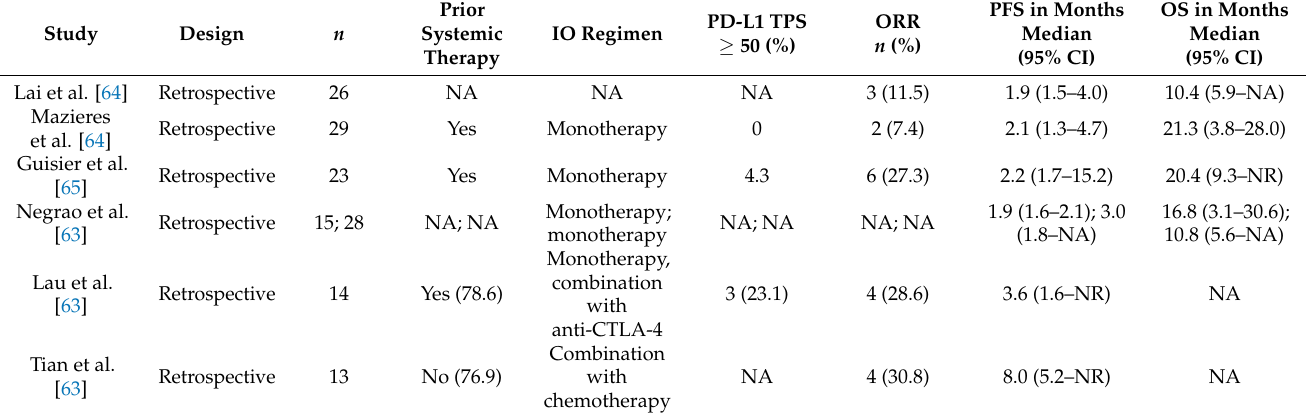
Table 2. Studies evaluating PD-1 axis blockade in patients with NSCLC harboring HER2 aberra- tions. NSCLC, non-small cell lung cancer; HER2, human epidermal growth factor receptor 2; PD-1, programmed cell death protein 1; IO, immunotherapy; PD-L1 TPS, programmed death-ligand 1 tumor proportion score; ORR, objective response rate; PFS, progression-free survival; CI, confidence intervals; OS, overall survival; NA, not available; NR, not